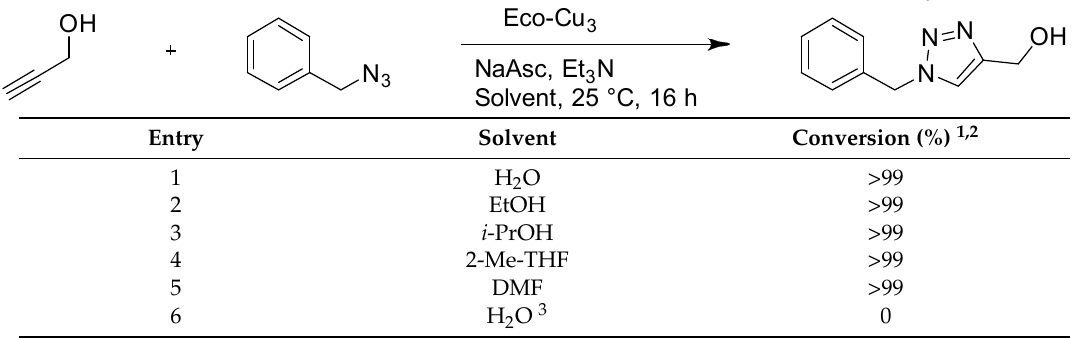
(Table 10): Very good conversions were obtained in green solvents, such as water, ethanol, isopropanol, or 2-methyltetrahydrofuran. Table 10. The influence of the solvent on the CuAAC Click reaction with Eco-Cu 3 .